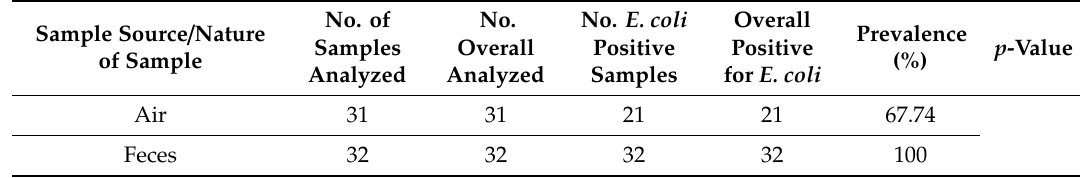
Table 2. Prevalence of E. coli in layer